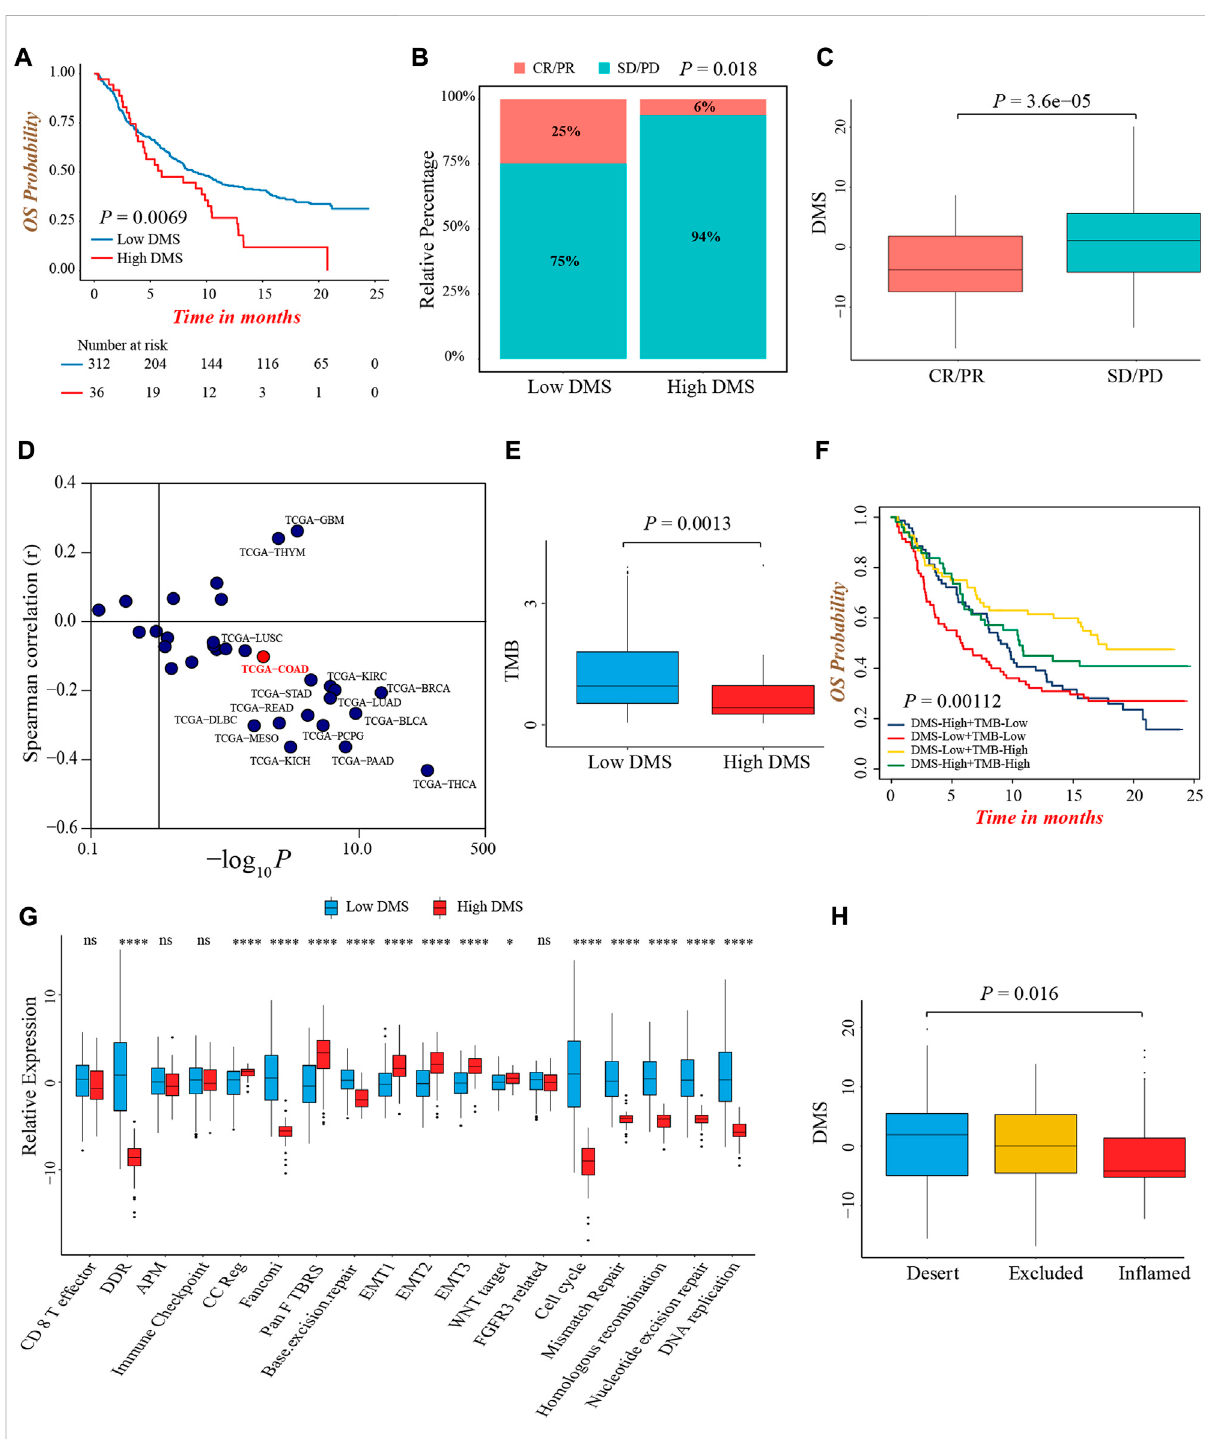
The predictive value of DMS in immunotherapy. (A) Overall survival analysis for low and high DMS groups in the IMvigor210 cohort (Log-rank test, p = 0.0069). (B) The proportion of patients with response to immunotherapy between DMS-high and -low groups in the IMvigor210 cohort (Chi-square test, p = 0.018). SD, stable disease; PD, progressive disease; CR, complete response; PR, partial response. (C) Comparison of DMS between immunotherapy response and non-response groups in the IMvigor210 cohort (Wilcoxon test; p < 0.0001). (D) Correlations between DMS and PD-L1 expression in pan-cancer cohorts through Spearman analysis (spearman correlation analysis). (E) Comparison of TMB between DMS-high and -low groups in the IMvigor210 cohort (Wilcoxon test; p = 0.0013). (F) Survival analyses for subgroup patients strati fi ed by both DMS and TMB in the IMvigor210 cohort (Log-rank test; p = 0.00112). (G) The differences in biological processes signatures between DMS-high and -low groups in the IMvigor210 cohort (Wilcoxon test; ns: no signi fi cance; * p < 0.05; ** p < 0.01; *** p < 0.001; **** p < 0.0001). (H) Differences in DMS among distinct tumor immune phenotypes in the IMvigor210 cohort. (Kruskal-Wallis test; p =